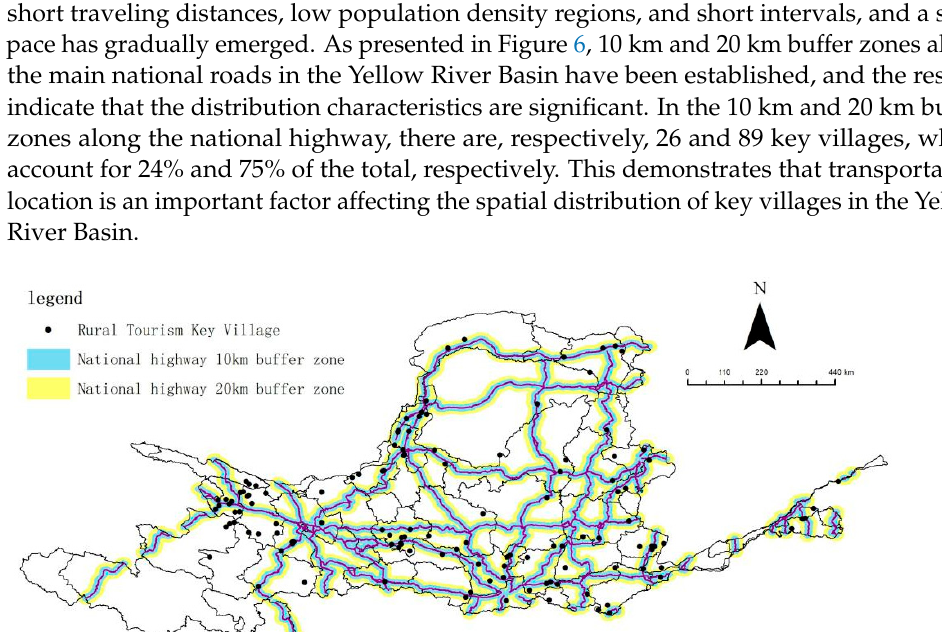
Figure 5. Ancient Silk Road Map of Key Rural Tourism Villages in the Yellow River Basin.